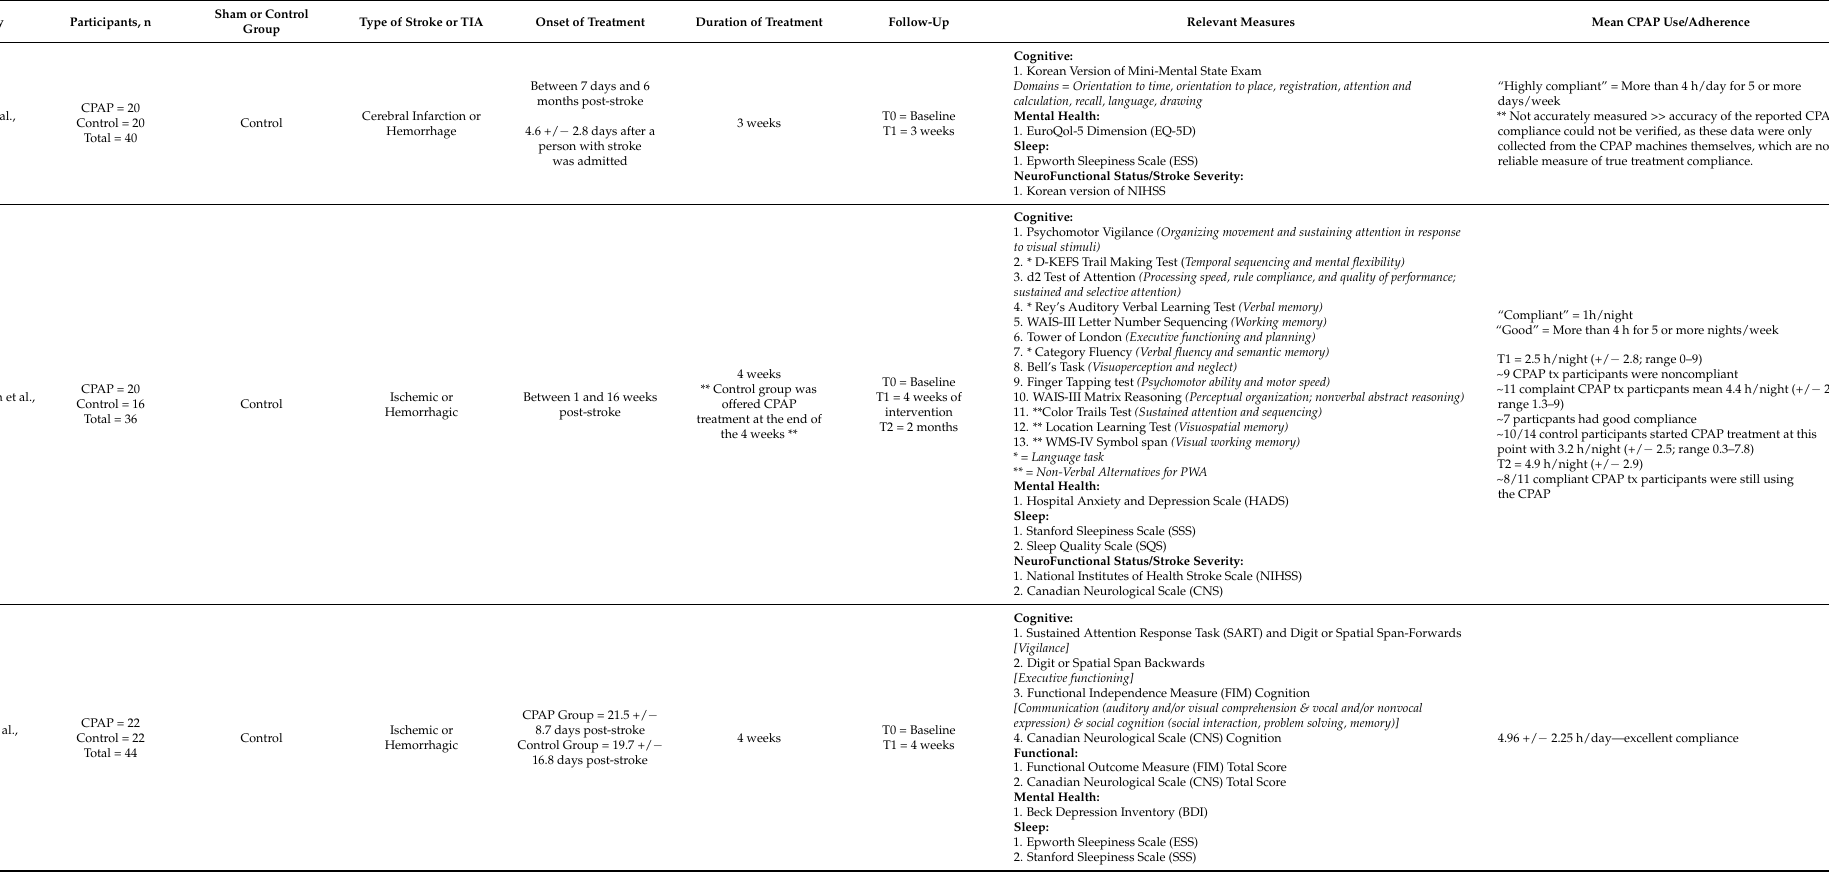
Table 2. Characteristics of Included